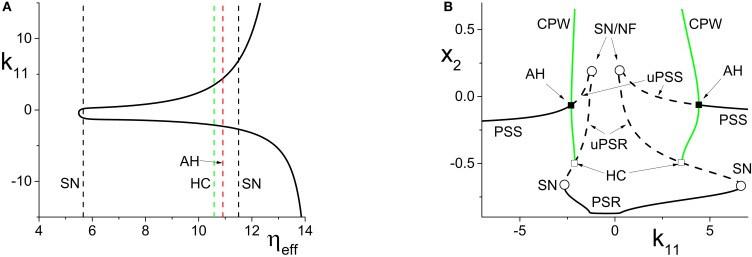
(A) The non-linear behavior of ηeff as a function of k11 for the inhibitorily-coupled response system. ηeff is plotted horizontally to facilitate comparison with Figure 3A. (B) The one-dimensional bifurcation diagram showing the asymptotic value of x2 = Im(z2) vs. k11. Solid and dashed black curves indicate stable and unstable equilibria, respectively, and green represents the maxima and minima of a CPW limit cycle state. The parameters are: η1 = −0.05, Δ1 = 0.05, η2 = 5, Δ2 = 0.5, and k22 = −9. The inter-population coupling is fixed at k21 = 3.5.